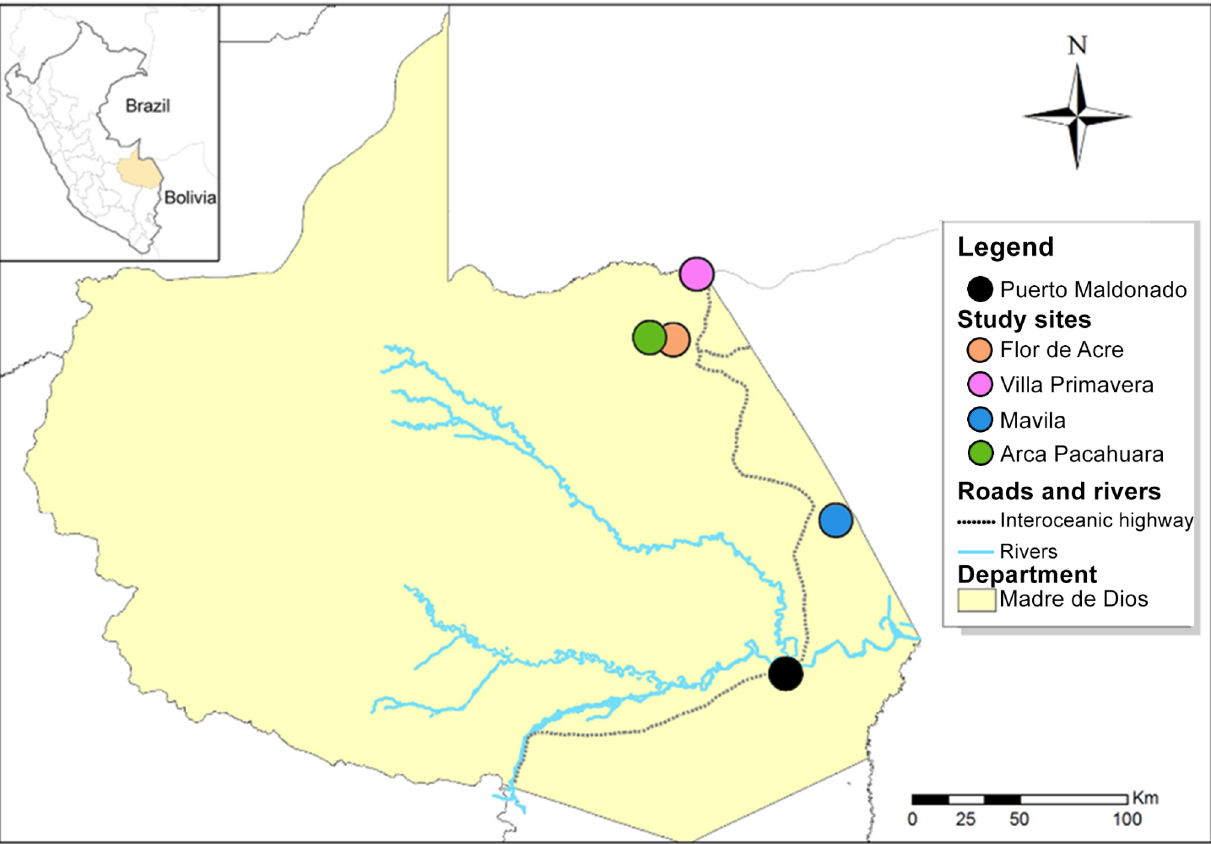
Fig 1. Map of the study area. This figure illustrates the Peruvianregionof Madre de Dios and its capitalcity (Puerto Maldonado) crossed by the interoceanichighway.Collectionsites are showedas points in the map as colored circles.